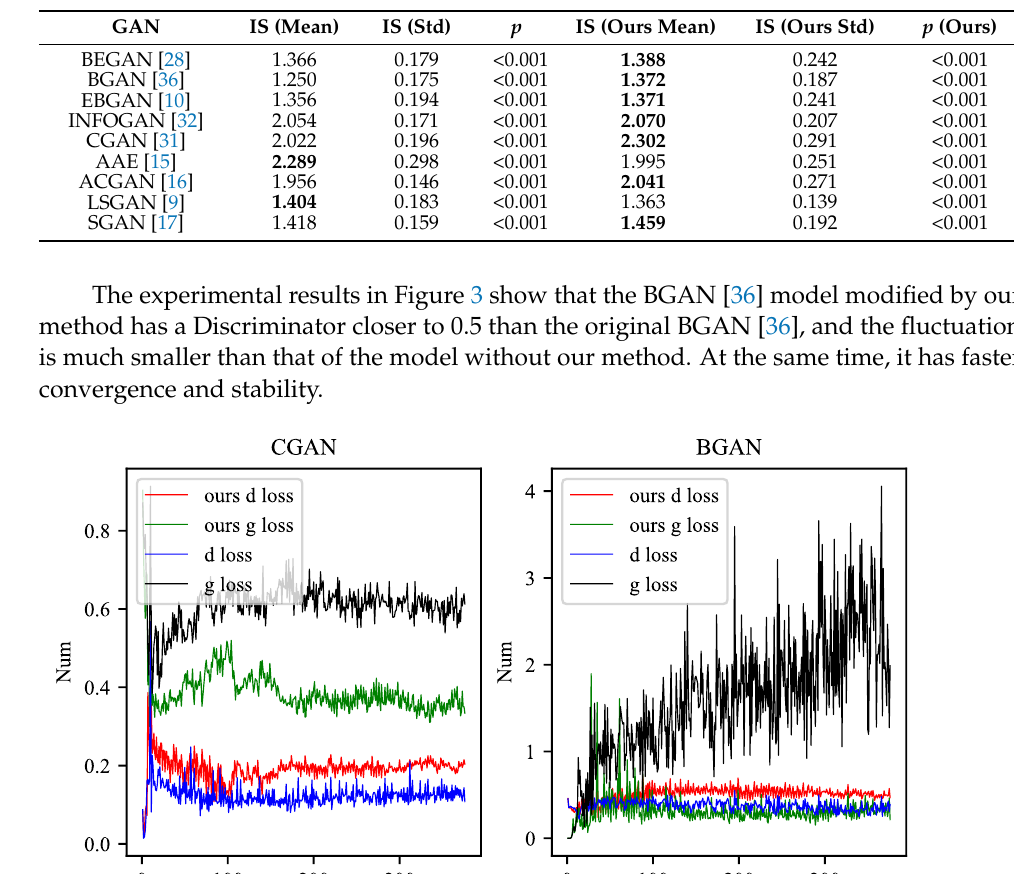
Table 1. Score (IS) test on GANs (MNIST).